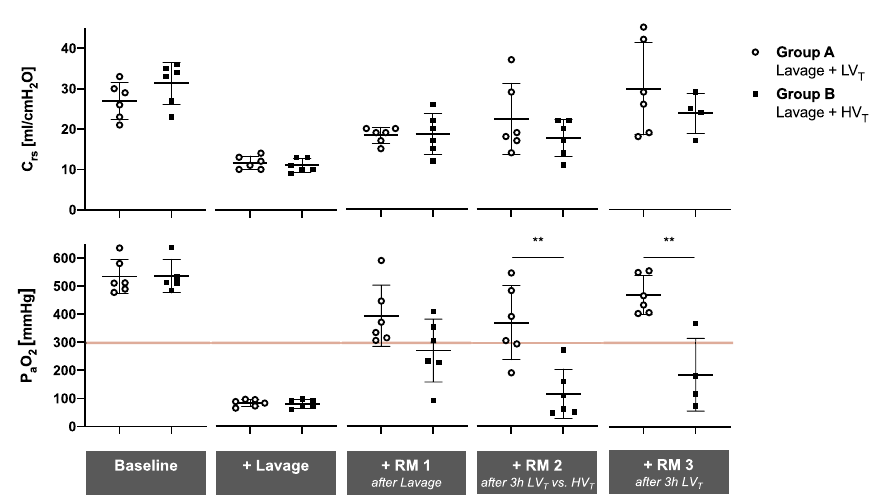
Fig. 2 Respiratory mechanics and function. Dynamic compliance of the respiratory system ( C rs ) and arterial partial pressure of oxygenation (P a O 2 ) were assessed in anesthetized pigs at baseline, after lavage-induced surfactant depletion, and after consecutive recruitment maneuvers (RM) at 3 h intervals. Group A, N continuous automated protective low tidal volume ventilation (LV T ). Group B, N volume ventilation (HV T ) prior to RM 2, resumption of protective low tidal volume ventilation for 3 h prior to RM 3. Two animals died after injurious HV T and RM 2, i.e., Group B, N see Fig. 1. Scatter plots with horizontal (means) and error bars (SD). ** p < 0.01, Mann–Whitney U test